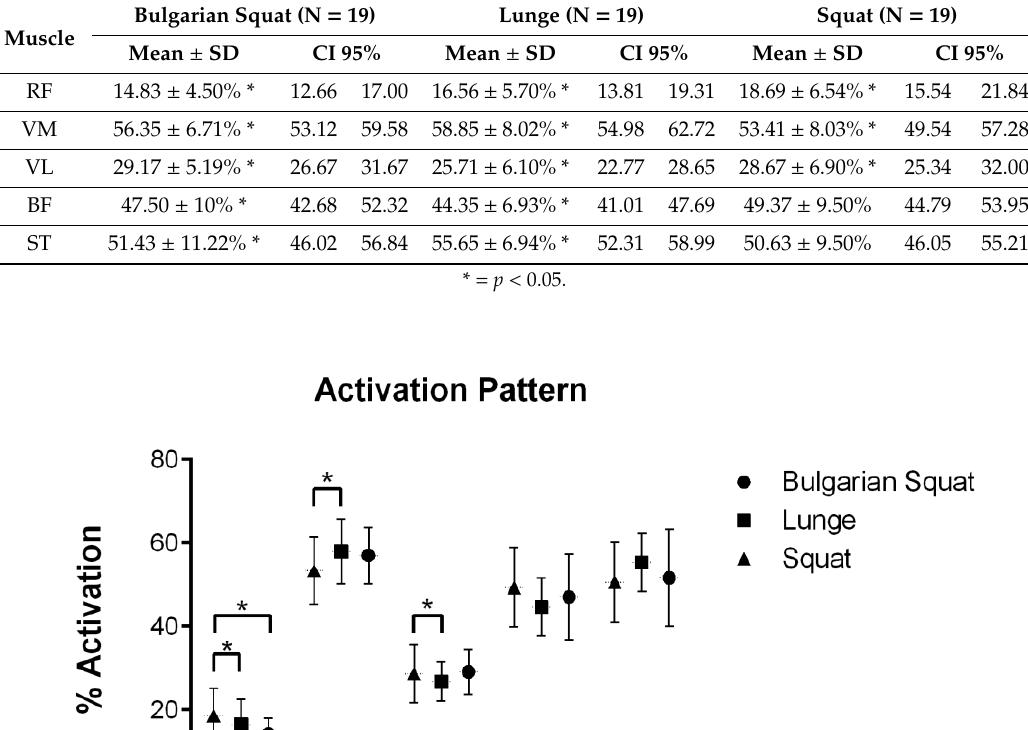
Table 1. Intra-muscular group activation (mean ± standard deviation) in percentage.